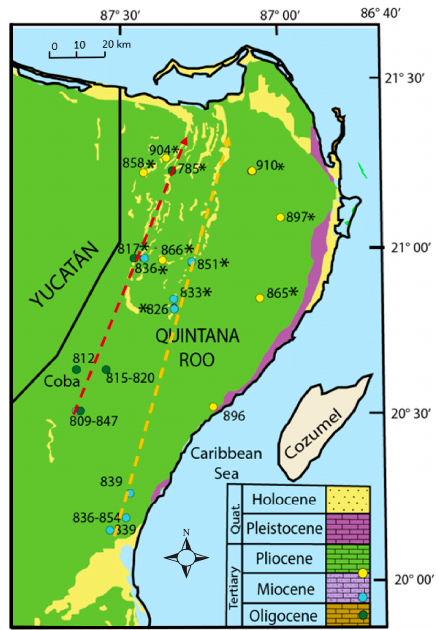
Figure 3. Map showing 87 Sr / 86 Sr values (in thousands place) and geology of Yalahau region sites. Southern locations are from a study by Perry et al. [7] while sites with a * are from this study. Red arrow indicates potential path of flow for Western Yalahau Fracture Zone. Orange arrow indicates potential path of flow for Eastern Yalahau Fracture Zone (modified from